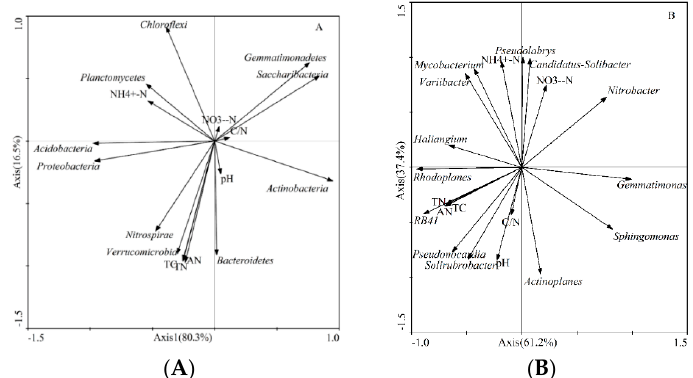
Figure 6. Redundancy analysis (RDA) on soil dominant bacteria phyla ( A ) and soil dominant bacteria genera ( B ) constrained by soil variables. TC: total C; TN: total N; AN: available nitrogen. Pearson correlation analysis of the dominant bacterial groups and soil environmental factors indicated that the relative abundance of Proteobacteria was positively correlated with NH 4+ –N ( r = 0.515,